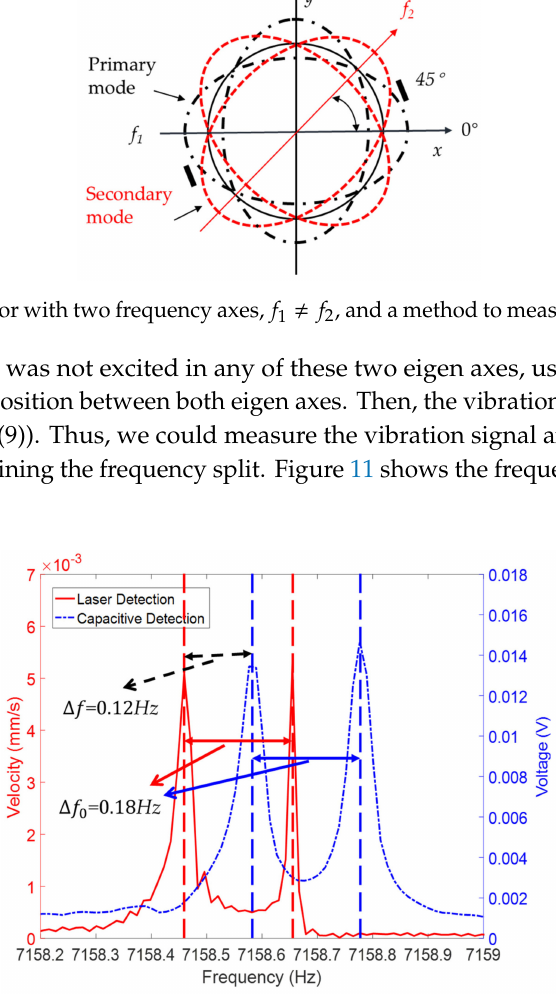
Figure 11. The frequency split measured by laser Doppler vibrometer (LDV; red) and capacitive detection (CD;